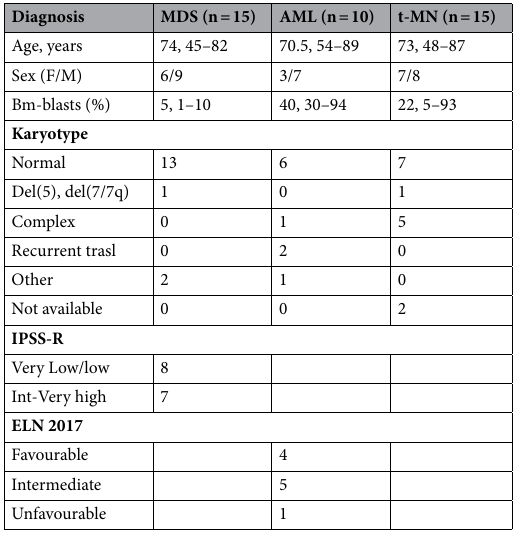
Table 1. Patient characteristics. Age and BM-blasts are reported as median and